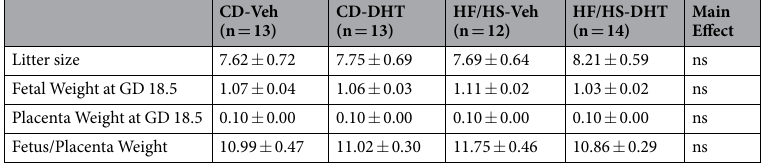
Table 1. Litter size, fetal and placental weight. GD: Gestational day; CD, control diet; HF/HS, high fat diet; Veh, vehicle; DHT, dihydrotestosterone. ns: no significance. Data are Mean values ± SEM and were analyzed by 2-way ANOVA to investigate interactions between maternal diet and DHT injection or main effect of either maternal diet or DHT. There was no interaction between maternal diet and the DHT injection in any variables studied.